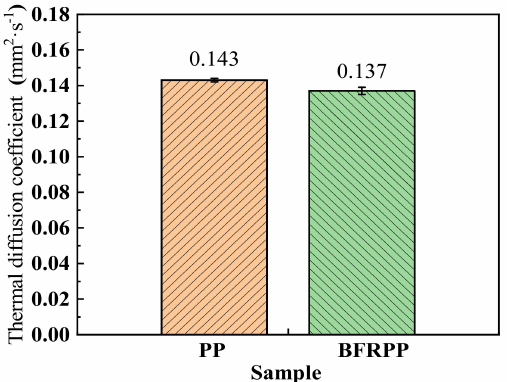
Figure 12. The thermal di ff usivity of the PP and BFRPP.